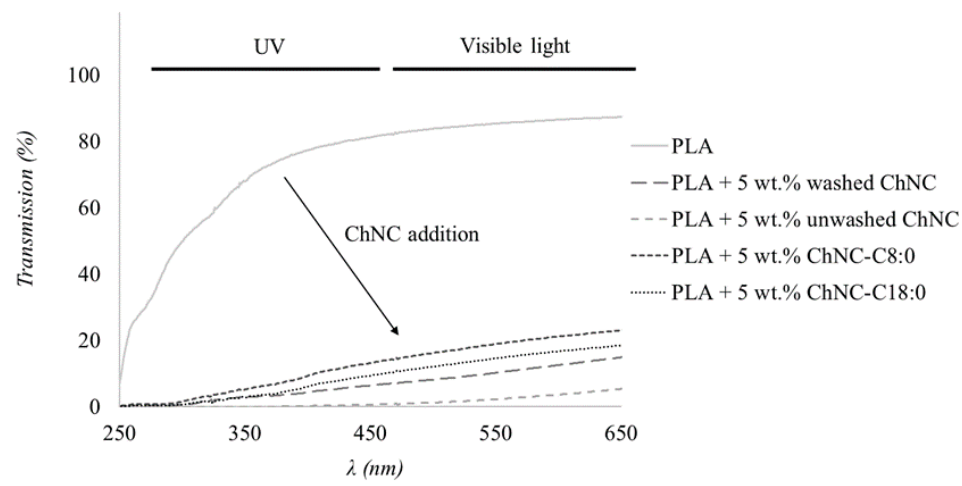
Figure 7. Transmittance of PLA films containing 5 wt.% (modified) ChNC. Wavelengths in UV and visible ranges are highlighted. Table 3. Water vapor transmission rate (WVTR) of PLA nanocomposites containing 5 wt.% (modified)